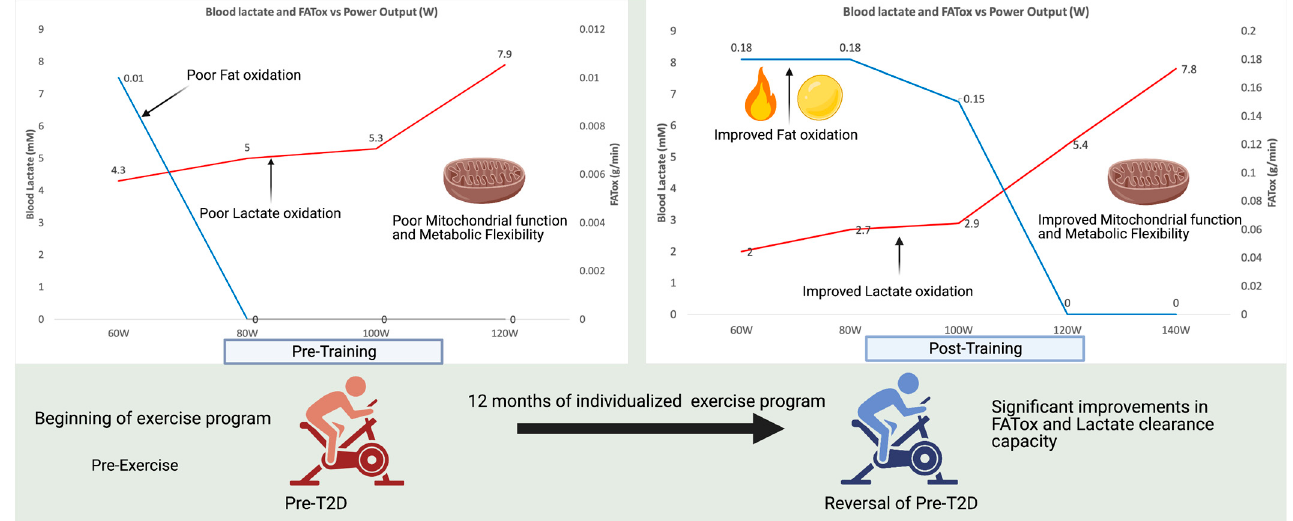
Figure 4. Example of the metabolic improvements of an individualized prescription exercise program on a patient diagnosed with pre–type 2 diabetes before and 12 months after completion of the exercise program. After the individualized exercise program was completed, there was a significant improvement in lactate clearance capacity and FATox, indicating an improvement in mitochondrial function (Source: San–Millan’s